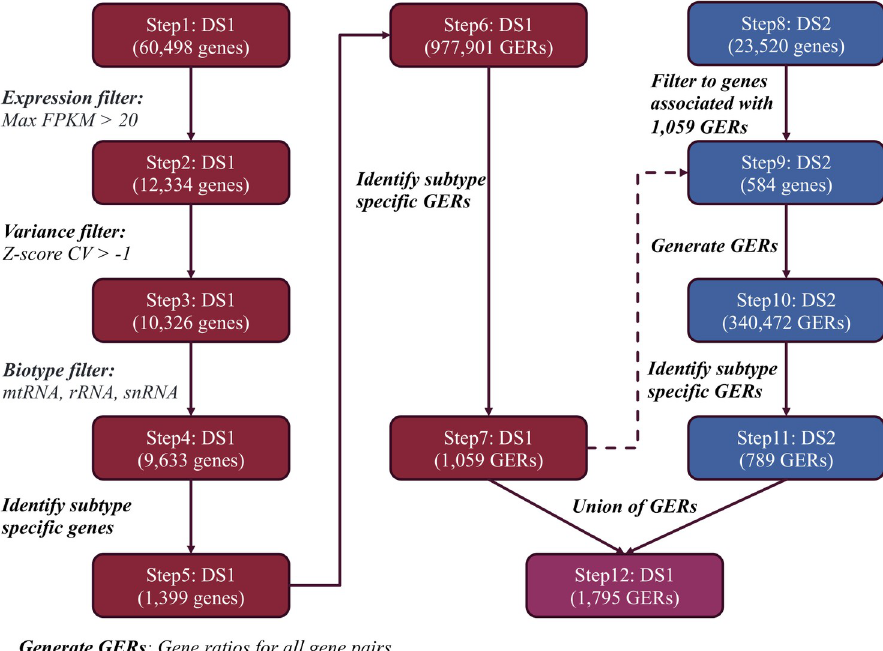
Fig 1. Medulloblastoma subtype-specific feature selection workflow. Workflow of identifying MB subtype-specific GERs using two transcriptomic data sets. DS1 represents the RNA-seq dataset EGAD00001001899 and DS2 represents the Microarray dataset